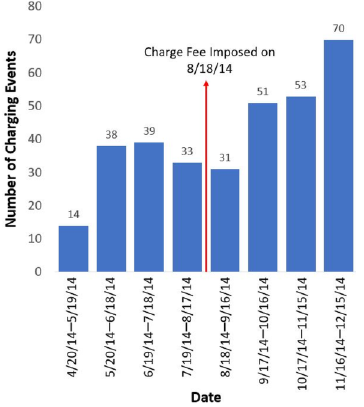
Figure 9. Frequency of charging events from four 30-day periods before and after electricity fee was implemented. Onset of electricity fee indicated with arrow.